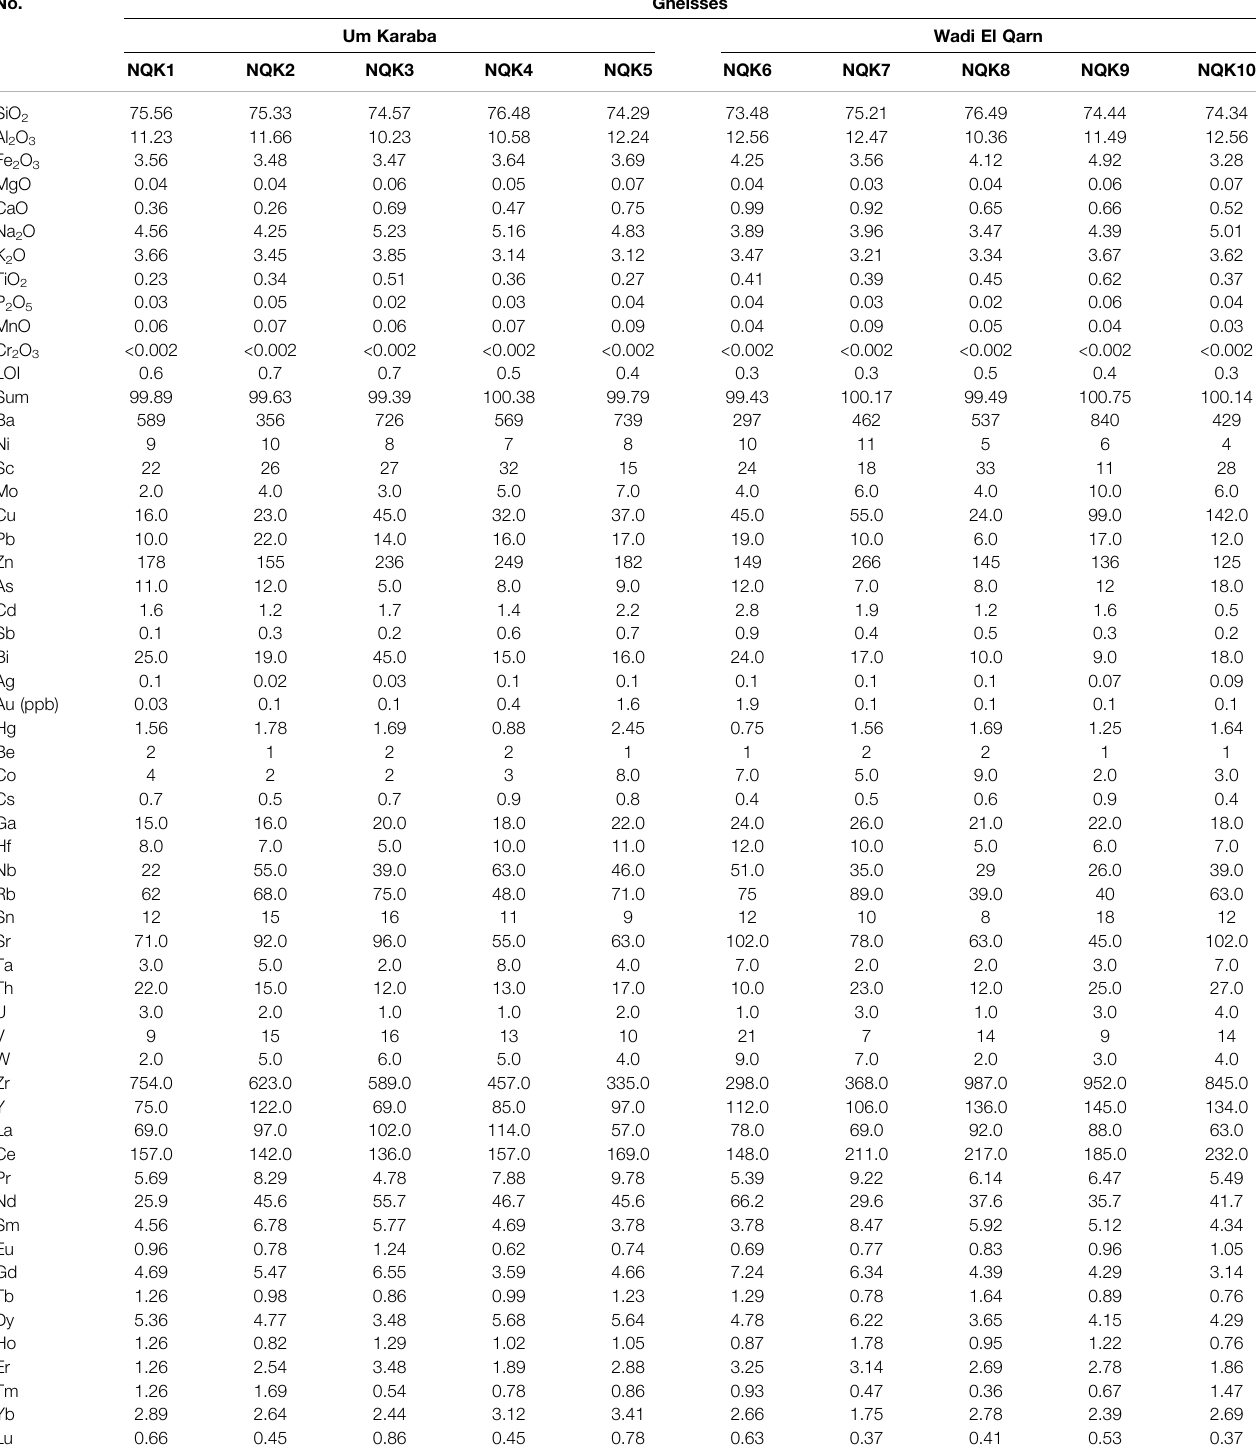
TABLE 2 | Whole rocks (major, trace and REEs) of Um Karaba and Wadi El Qarn gneisses rocks.